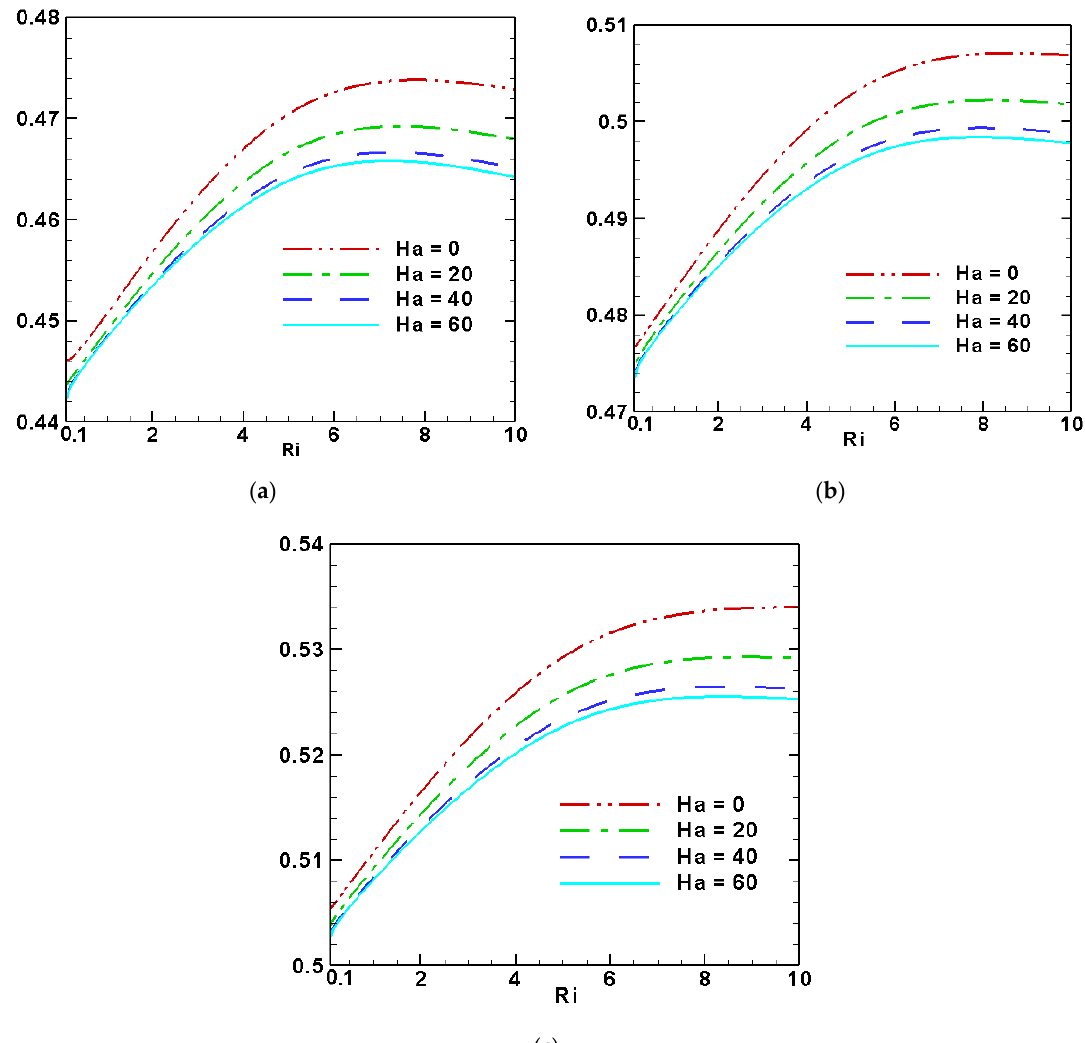
Figure 9. θ av for ( a ) L = 0.25, ( b ) L = 0.35 ( c ) L = 0.45 at λ = 2 and Re = 100.